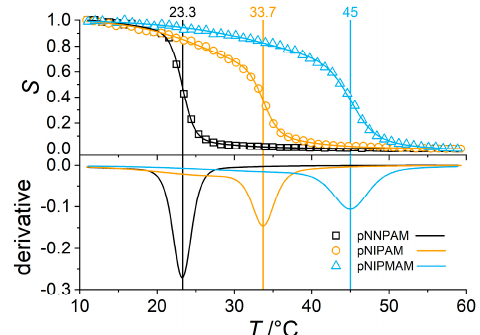
Figure 3. ( Top ) Normalized swelling curves of the size ranging from 0 to 1 of pNNPAM (1.9 mol% BIS), pNIPAM (5.0 mol% BIS), and pNIPMAM (10.0 mol% BIS) as a function of the temperature. The curves where measured in water for particles synthesized under identical conditions. ( Bottom ) Derivative of the fit describing the experimental data in the upper part of the figure. The vertical lines indicate the